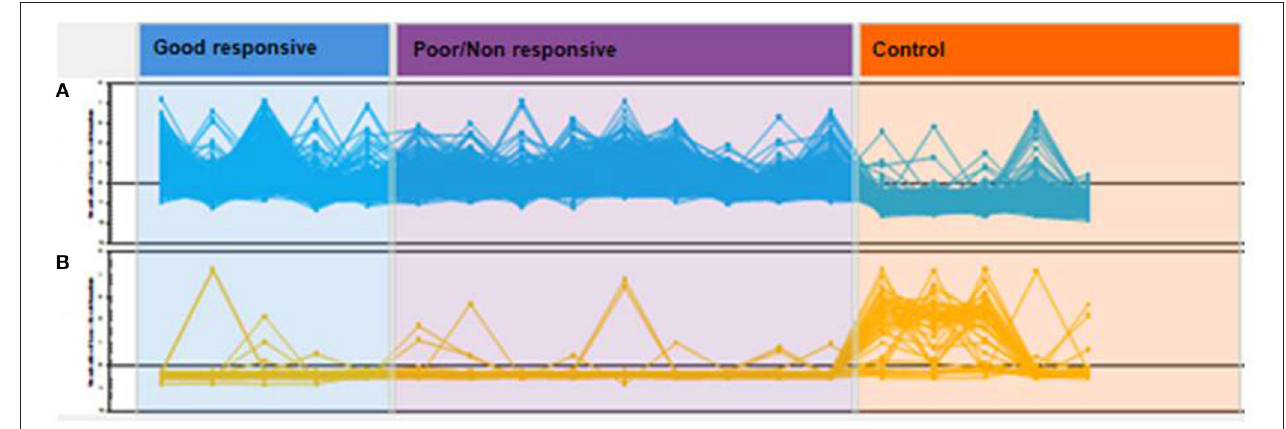
FIGURE 3 | Hierarchic cluster analyses (HCA) of global protein profiles. Each line represents a protein and each peak or valley, its abundance per patient. Proteins in (A) have a predominance of positive regulation in cases of good responsive nAMD and poor/non-responsive nAMD with the predominance of negative regulation in controls. In (B), the opposite relationship is